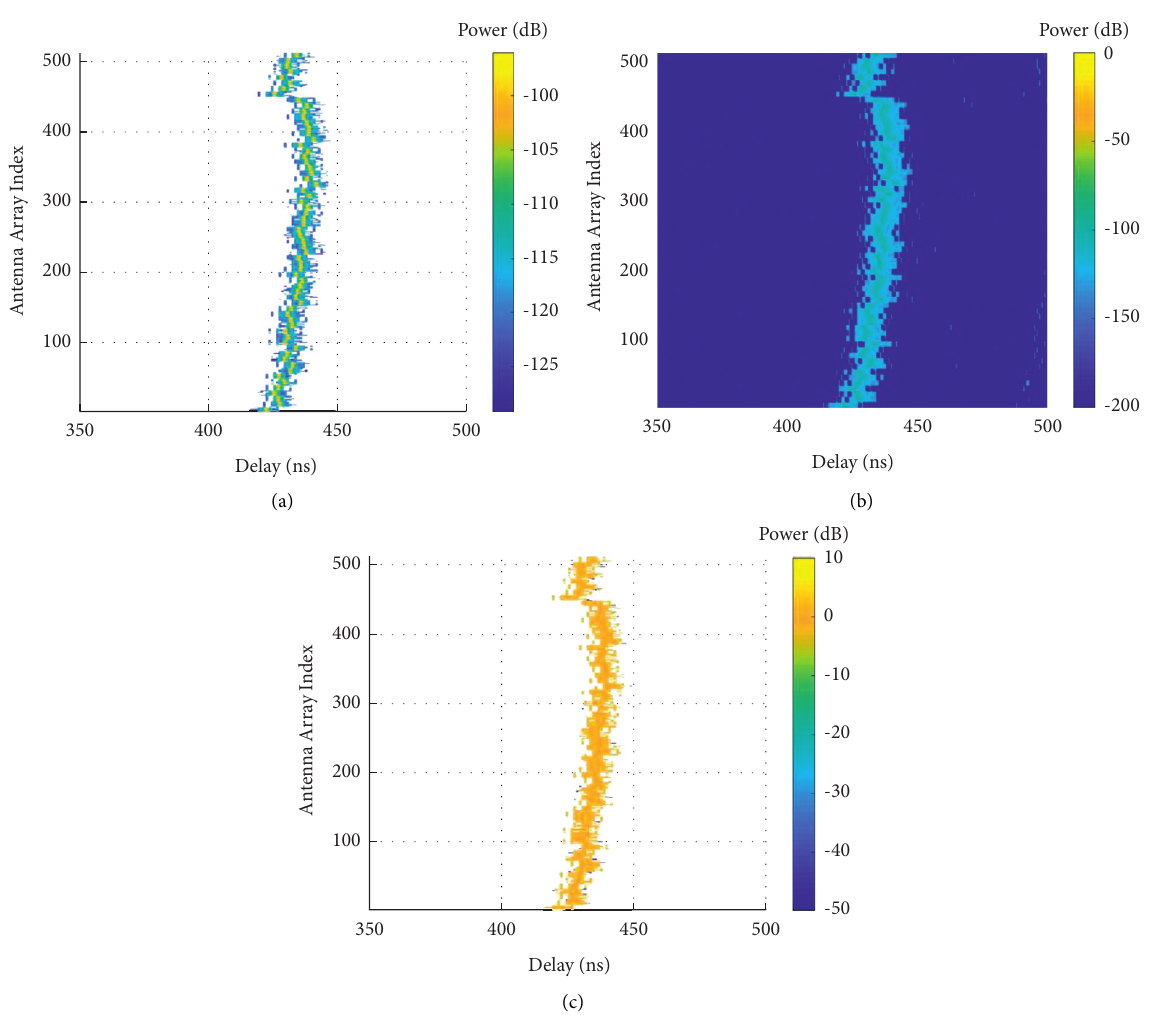
Figure 5: PDP of Rx-8 in LOS scenarios. (a) Measured PDP of Rx-8, (b) reconstructed PDP of Rx8, (c) residual PDP of